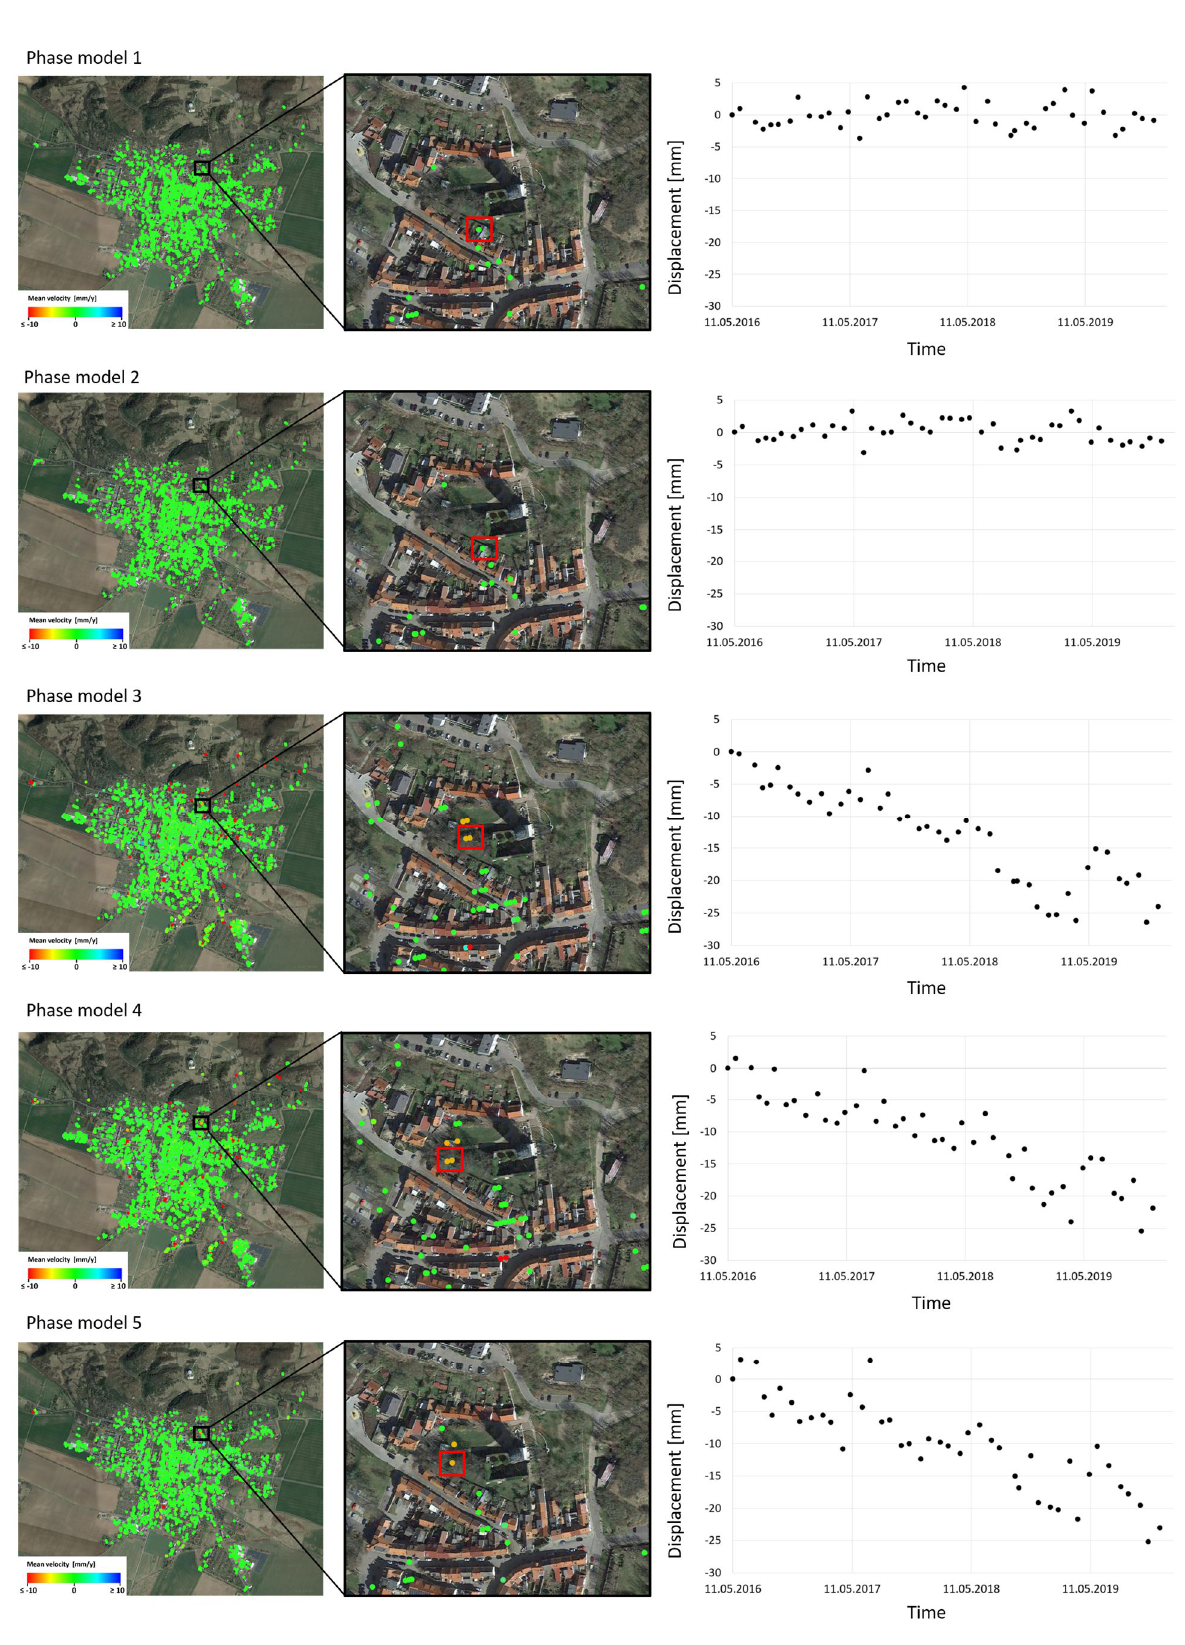
Figure 4: Time-Series displacements at the location of the Church Tower with different phase models; left: velocity map for the city of Bad Frankenhausen; middle: zoom-in to the church location; right: displacement